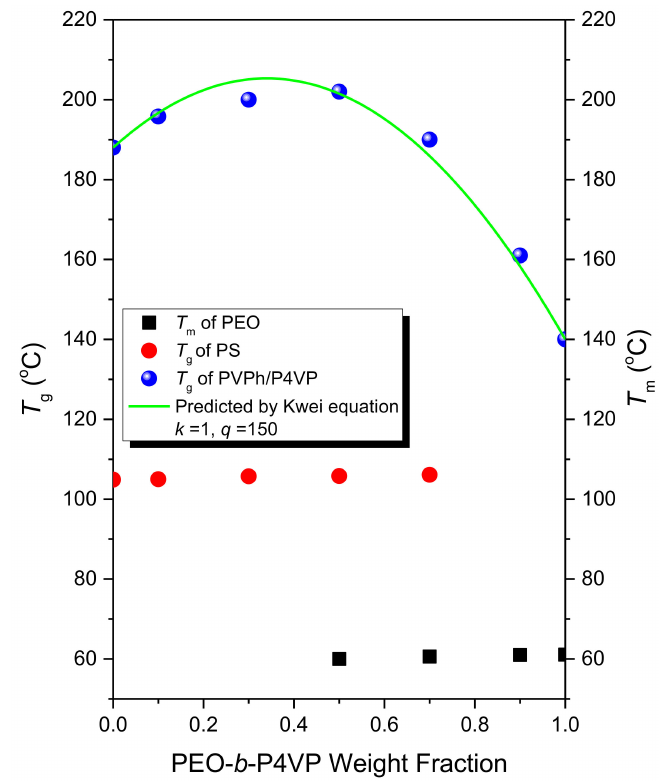
Figure 6. T g behavior of PS and PVPh/P4VP domain (also predicted by Kwei equation), and T m behavior of PEO segment of PS- b -PVPh/PEO- b -P4VP